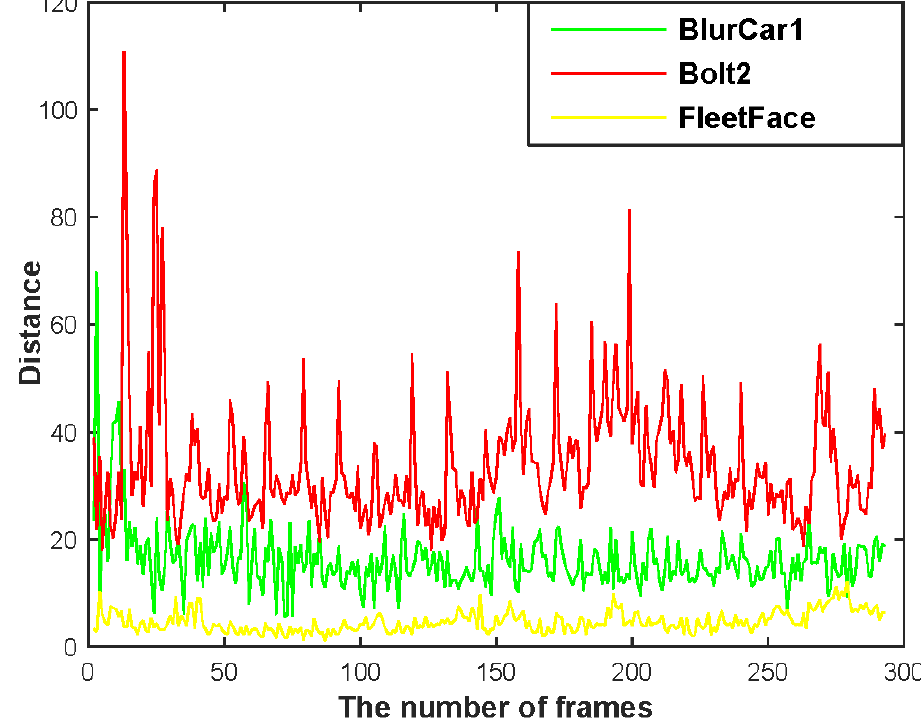
Figure 4. Visualization of the similarity distance between the current predicted result and the existing tracking results in the BlurCar1 (green curve), Bolt2 (red curve), and FleetFace (yellow curve). The similarity distance of different sequences is remarkably